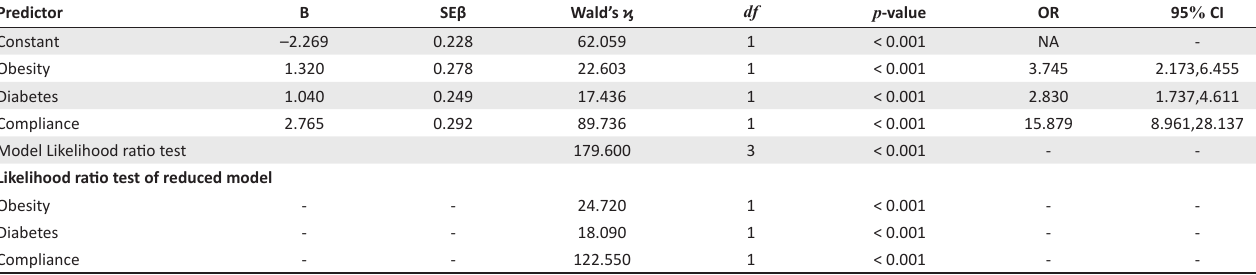
TABLE 2-A1: Multivariate logistic regression analysis for factors associated with uncontrolled blood pressure. Predictor Β